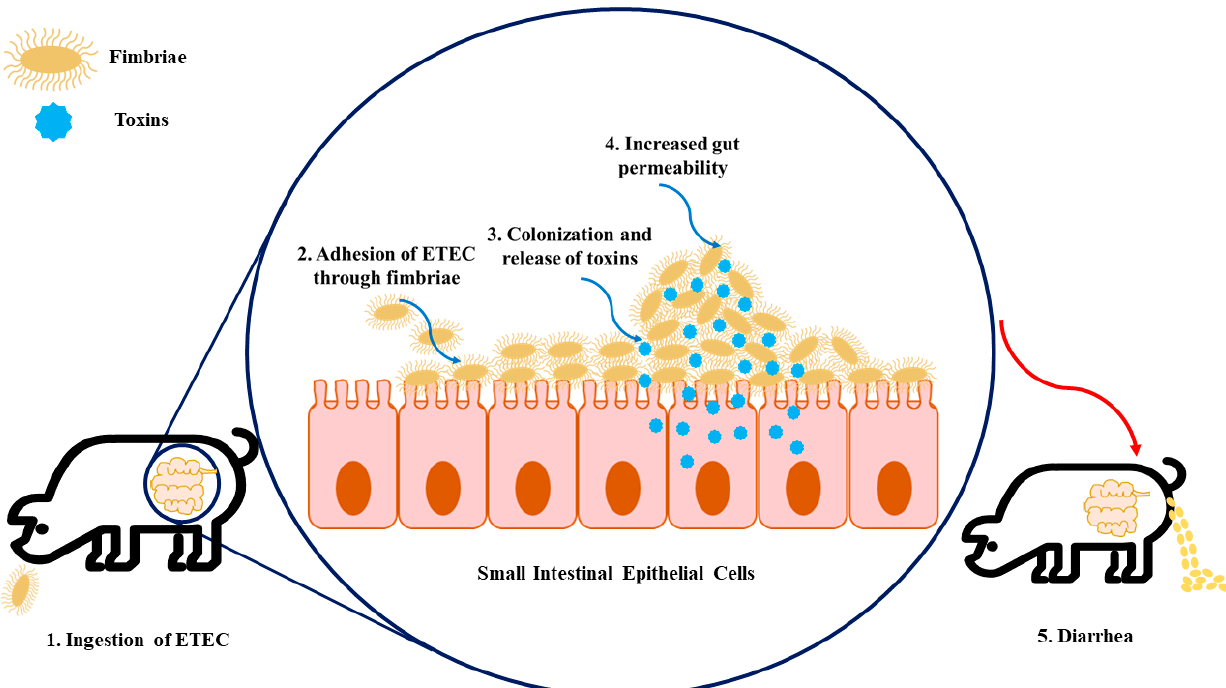
Figure 1. The infection model of enterotoxigenic Escherichia coli (ETEC) on intestinal epithelial cells. ( 1 ) Firstly, the swine ingest ETEC, enabling its transition to the gastrointestinal tract. ( 2 ) The fimbriae expressed by ETEC allow the adhesion of bacteria to specific receptors present in the intestinal epithelial cells. ( 3 ) Colonization arises in the small intestinal mucosa, which leads to the production of toxins. ( 4 ) These enterotoxins promote water and electrolyte loss into the intestinal lumen, resulting in increased gut permeability. ( 5 ) As a consequence of increased gut permeability and massive water loss, diarrhea, weight loss, and mortality can happen.